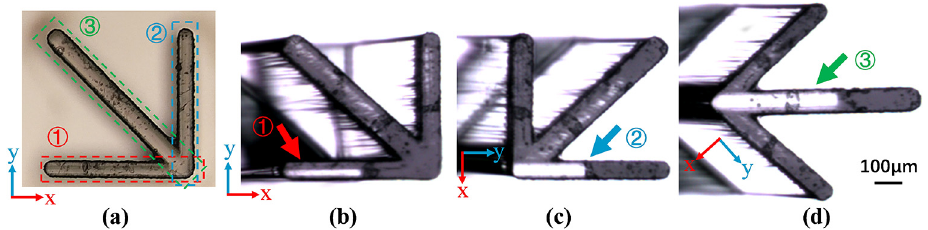
Figure 8. ( a ) Optical microscopic image of microstructures consist of three line segments; ( b ) optical detection image of the line segment ① ; ( c ) optical detection image of the line segment ② ; ( d ) optical detection image of the line segment ③ .